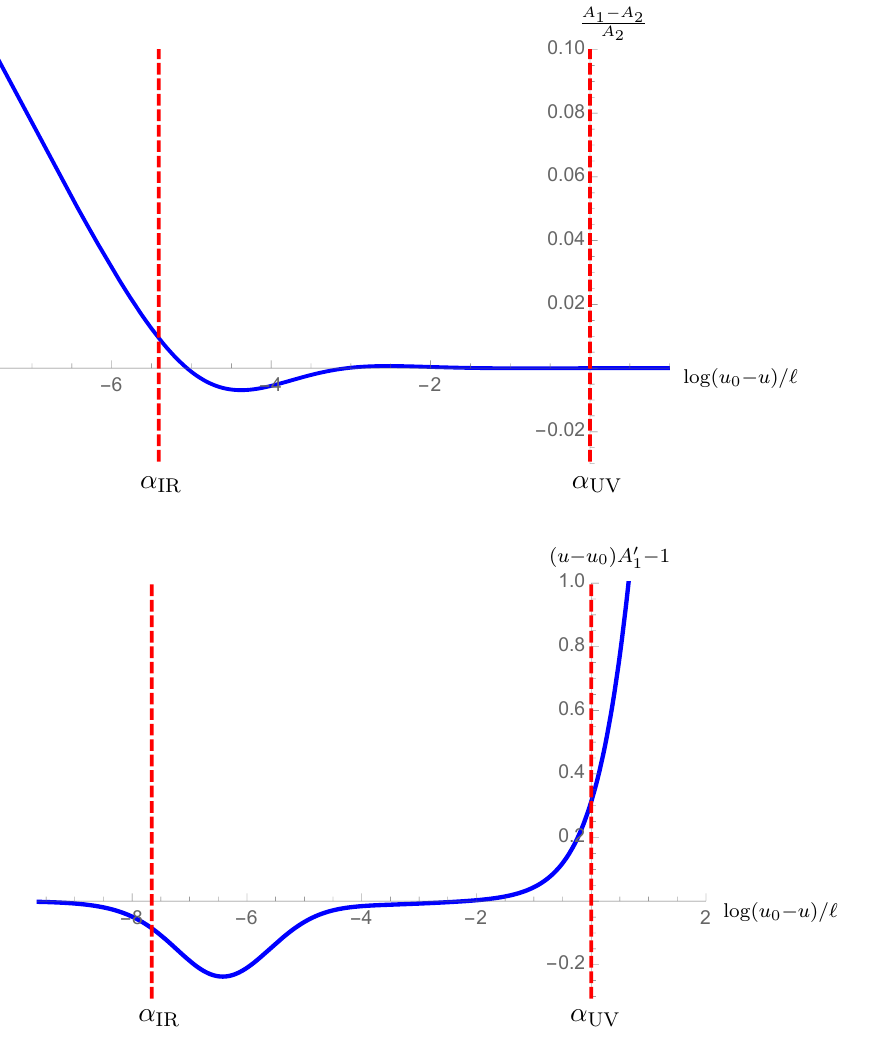
Figure 8 . These (cid:12)gures show the region of validity of equation (7.13), delimited by the red dashed lines corresponding to the boundary values in equation (7.8). The upper (cid:12)gure is a plot of the relative di(cid:11)erence between A 1 and A 2 , while the lower (cid:12)gure shows the relative di(cid:11)erence between _ A and ( u (cid:0) u (cid:0) 1 . Both are small in the region delimited by the dashed lines, con(cid:12)rming the validity 0 ) of equation (7.13) in this